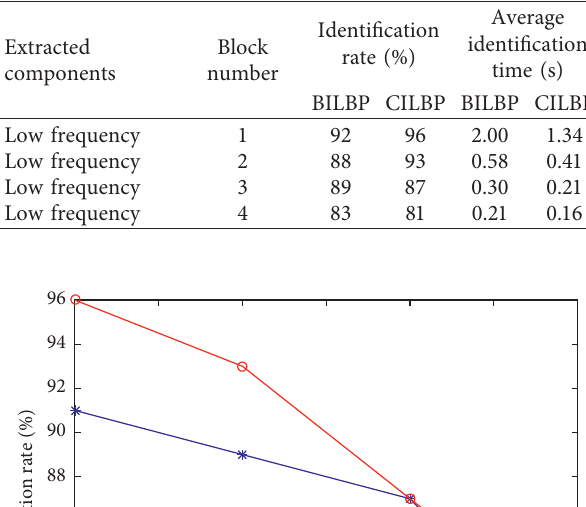
Table 3: Identification results with partition (1 × 4) and the blocks BILBP and CILBP.